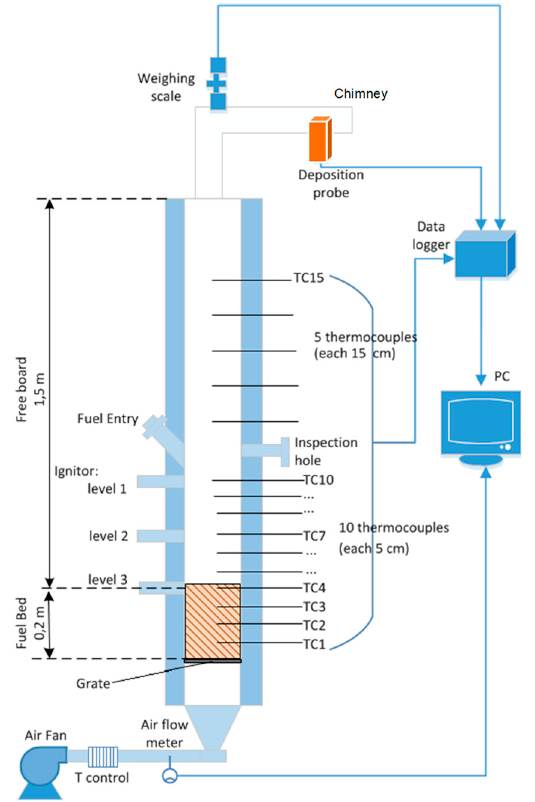
Figure 2. Scheme of the experimental test facility.